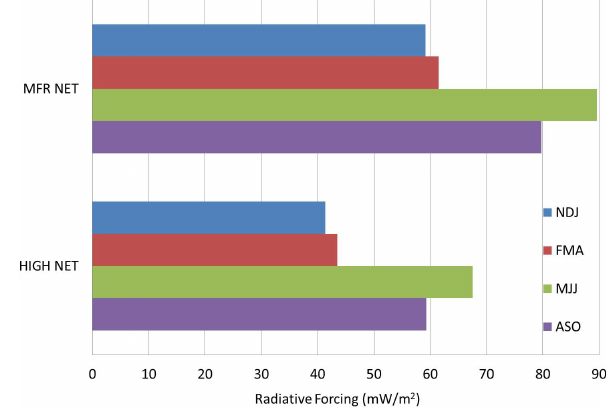
Fig. 6. Global RF (mWm − 2 ) from 2004–2030 per component for the scenarios HIGH and MFR. Fig. 7. Net global RF (mWm − 2 ) from 2004–2030 for different sea- sons for the scenarios HIGH and